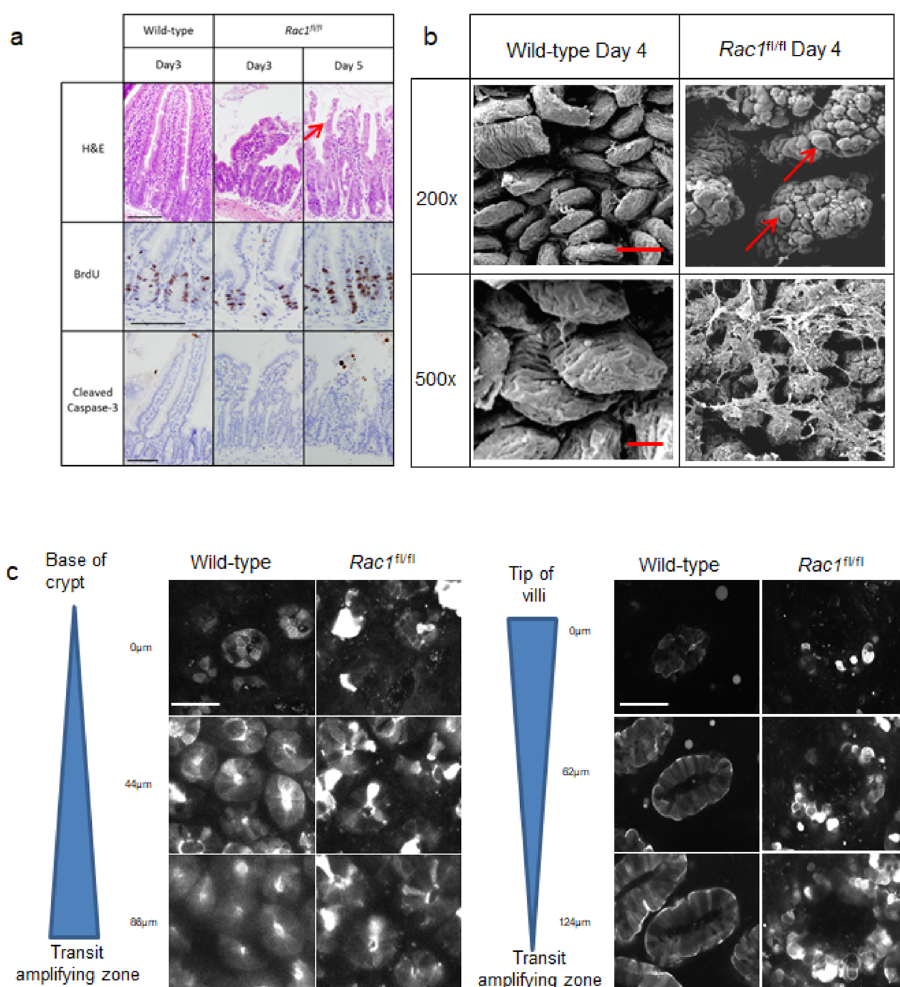
Fig. 1 Loss of Rac1 perturbs villus homeostasis. a Images showing H&E, BrdU incorporation and Cleaved caspase-3 IHC in Vil-CreER T2 (wild-type), Vil- CreER T2 Rac1 fl / fl ( Rac1 fl / fl ) mice day 3 post induction and Vil-CreER T2 Rac1 fl / fl ( Rac1 fl / fl ) mice 3 and 5 days post induction. Red arrow indicates disintegrating villus. Scale bar represents 100 μ m in each case (See ampli fi ed images in Supplementary Fig. 1d – f). b Scanning EM on Vil-CreER T2 (Wild-type) or Vil- CreER T2 Rac1 fl / fl ( Rac1 fl / fl ) intestines 4 days post induction. Red arrows indicate rounded, blebbing cells. Scale bar represents 100 μ m in the upper panels and 50 μ m in the lower panels. c Vil-CreER T2 driving expression of LifeAct -GFP in wild-type and Rac1 fl / fl intestines 4 days post induction. Scale bar represents 50 μ Fig. 1A indicating the regions of interest of the crypt-villus) and apoptosis (Fig. 1a and Supplementary Fig. 1C, F). To investigate